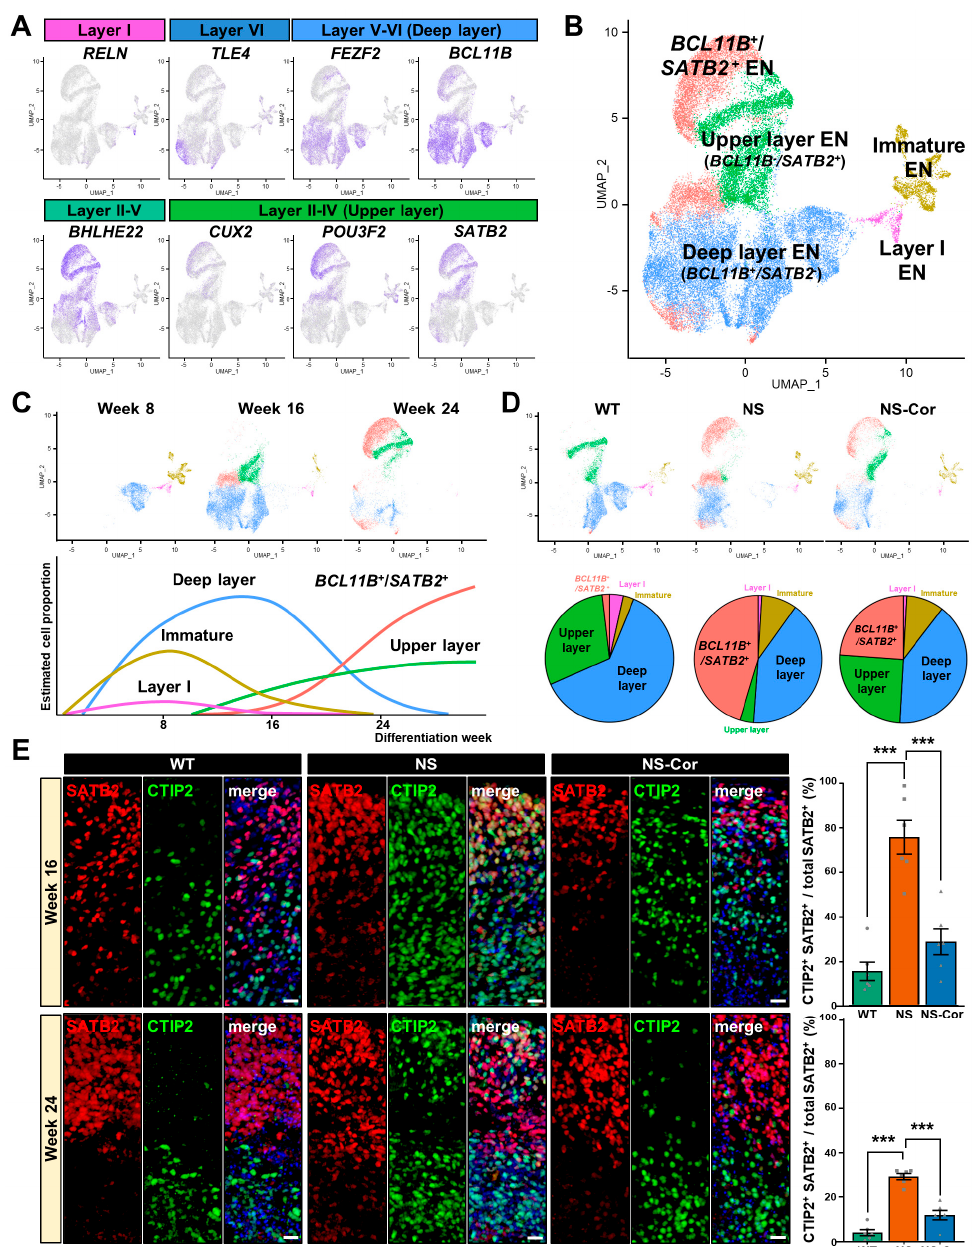
Figure 3. Disturbed regulation of cortical layer identity in NS-COs. ( A ) Distribution of the expression of cortical layer-specific genes in the EN subset. ( B ) UMAP plot of ENs. Clusters were annotated based on their respective layer-specific gene expression. ( C ) Laminar identity transition across cortical development. Schematic dynamics are drawn in accordance with the cell proportion at each time point. ( D ) Cortical layer distribution of respective COs. ( E ) Increased CTIP2 + /SATB2 + population in week 16, 24-NS-COs. Numbers of CTIP2 + /SATB2 + cells were counted in six organoids in each group with ImageJ. COs were obtained from three independent experiments. Data are presented as means ± SEM. p -values were determined with an unpaired Student’s t -test. *** p < 0.001. Scale bars, 20 μ m.